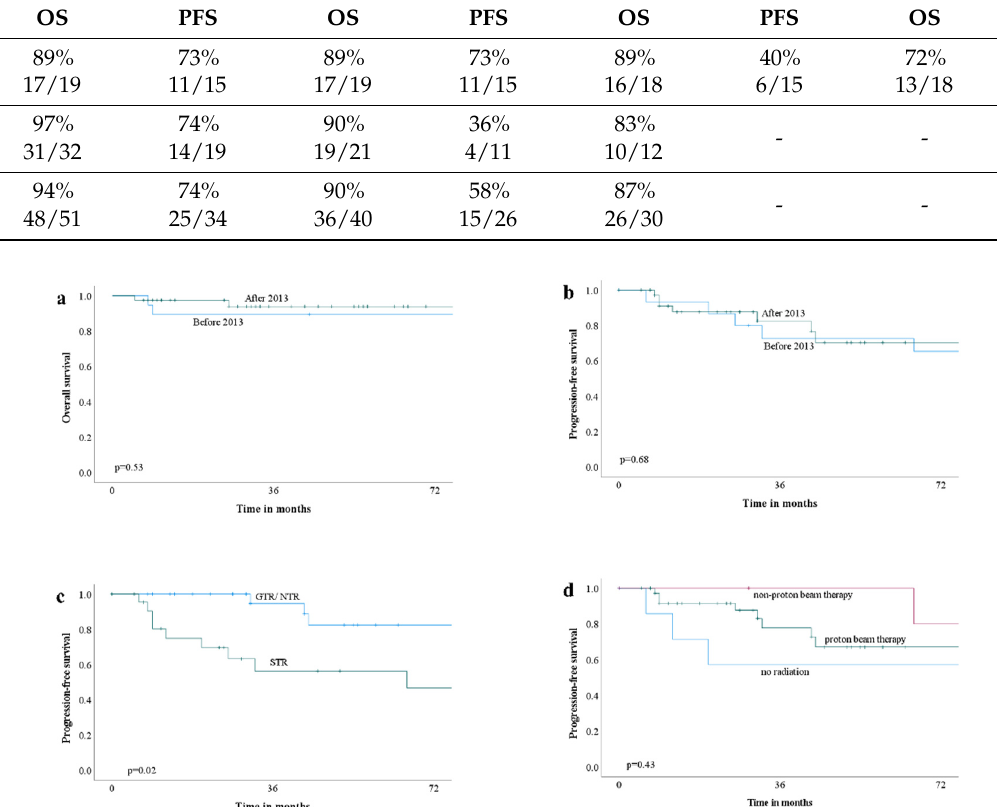
Figure 2. Kaplan–Meier curves of overall survival and progression ‐ free survival (PFS). ( a ) Overall survivals of “before 2013” and “after 2013”; ( b ) PFS curves of “before 2013” and “after 2013”; ( c ) PFS curves based on the resection degree; ( d ) PFS curves based on adjuvant radiation status.